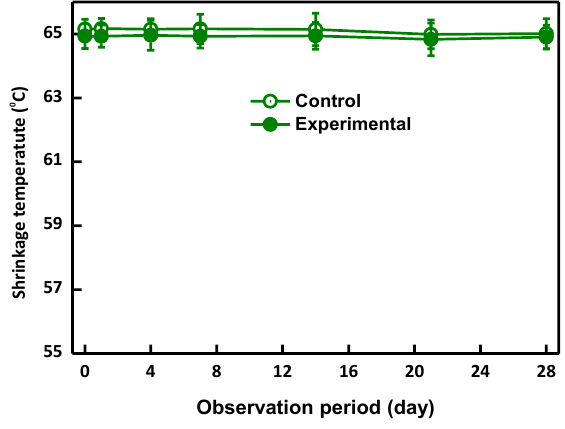
Figure 6. Changes in hydrothermal stability for preservation period